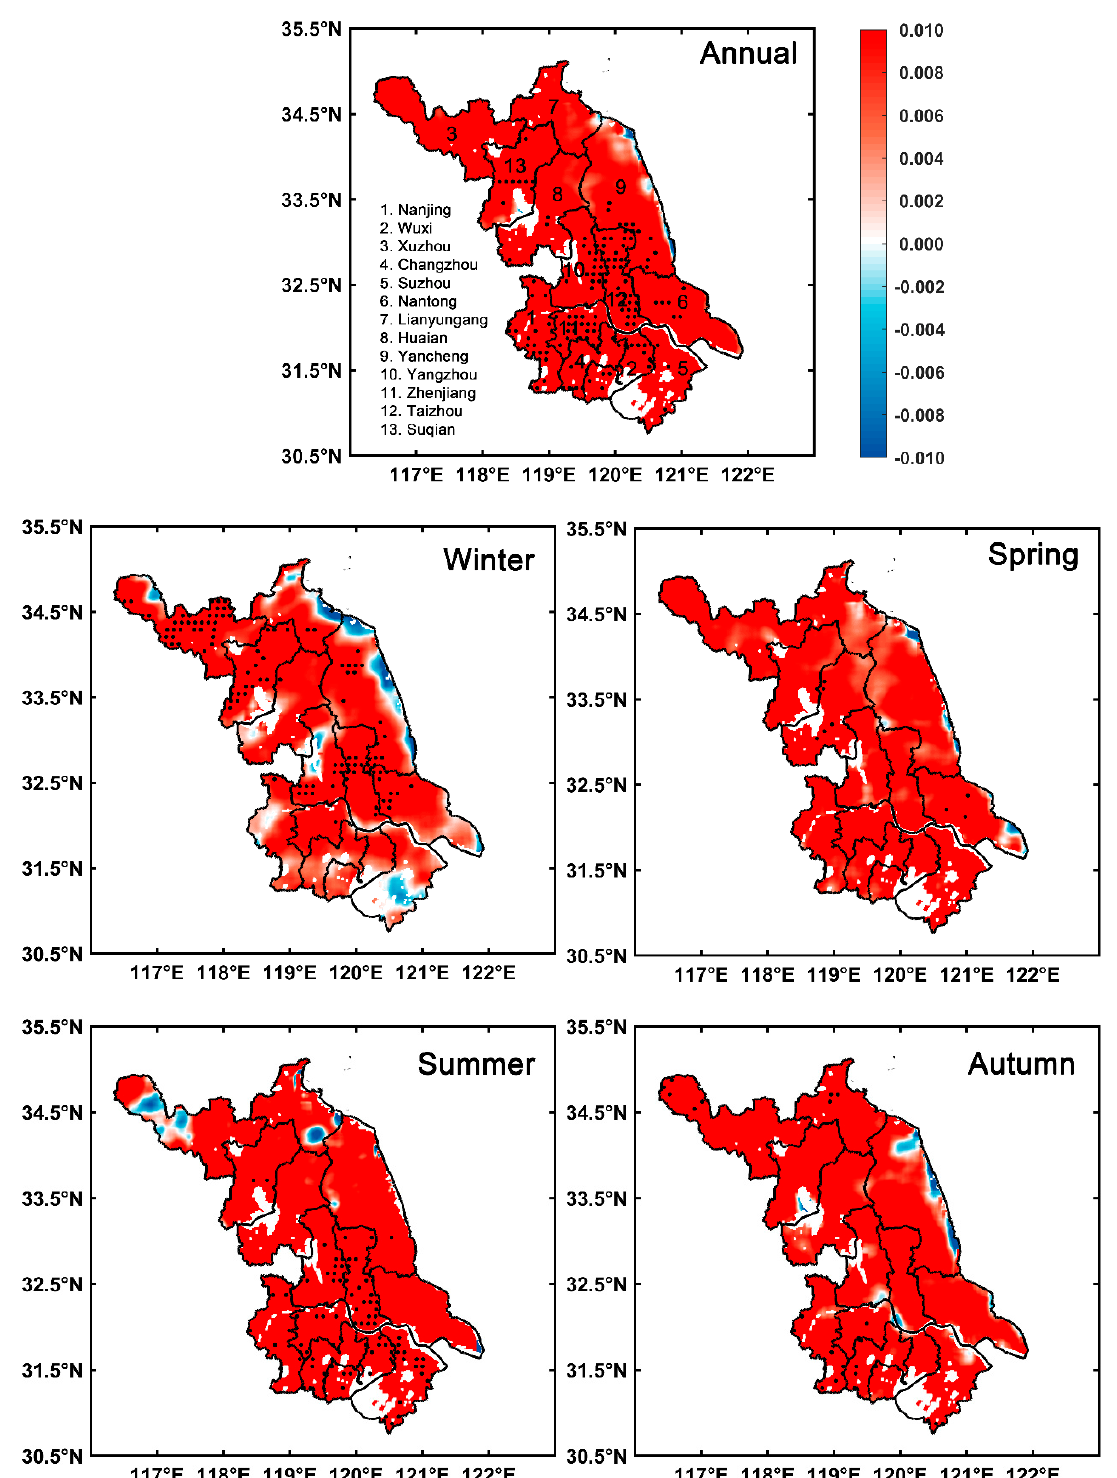
Figure 8. Annual and seasonal spatial trends of high-resolution MODIS MAIAC AOD from 2000 to 2009 in Jiangsu Province. The dot (.) symbol indicates significance at 95% confidence interval.